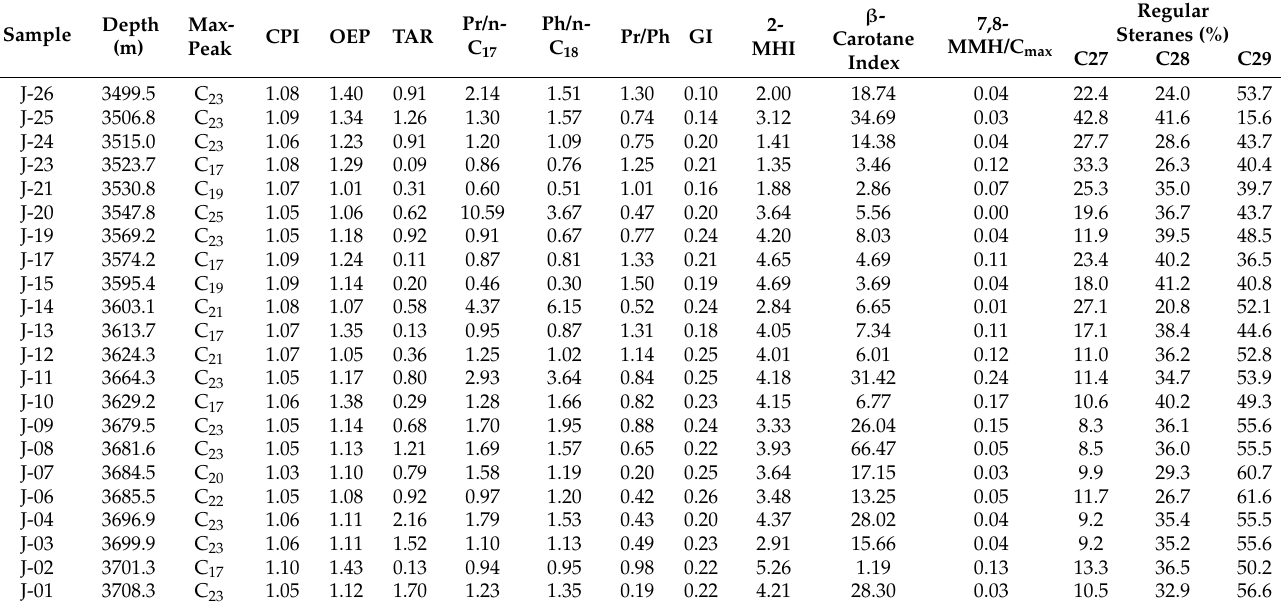
Table 2. Biomarker ratios of the Lucaogou